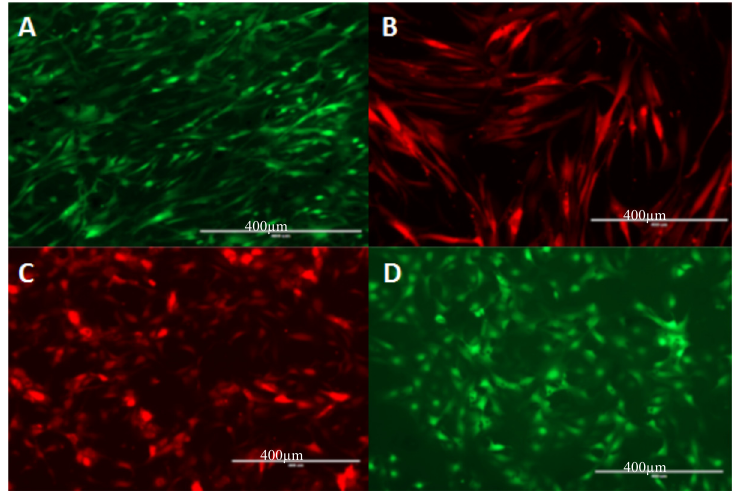
Figure 4. Microscopic analysis of different cell types seeded on PLA discs. ( A ) hOB (human primary osteoblasts; ( B ) normal human dermal fibroblasts: NHDF; ( C ) human umbilical vein endothelial cells: HUVEC; and ( D ) osteosarcoma cells: SaOS-2. Scale bars represent 400µm.